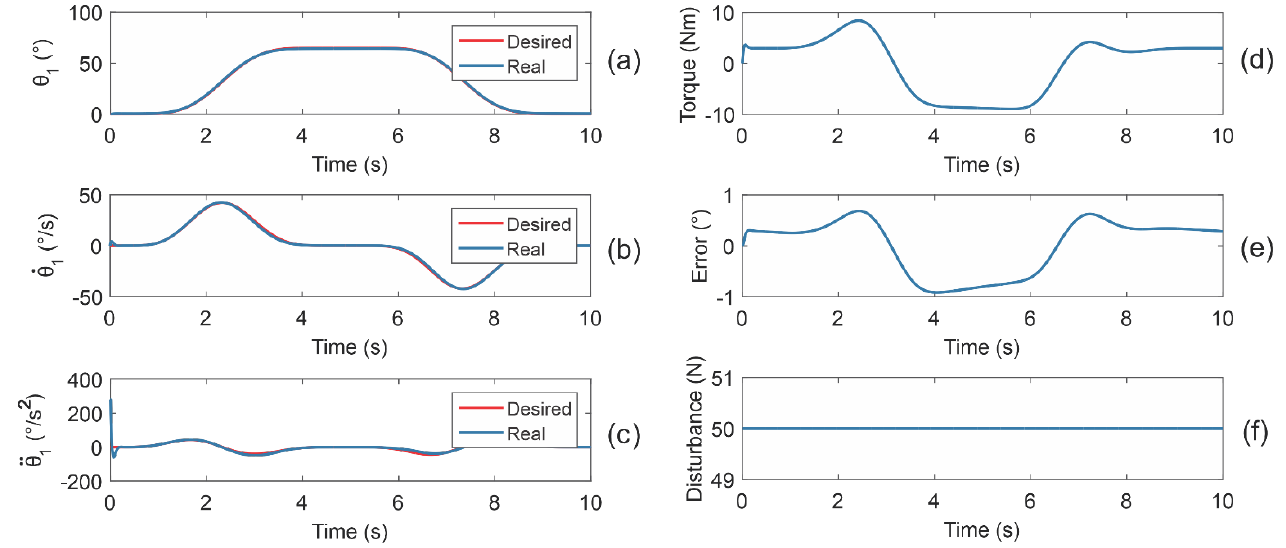
Figure 13. Reference trajectory tracking simulation with a constant disturbance input. ( a ), ( b ), and ( c ) are respectively the angular position, velocity, and acceleration of 𝜃 1 , ( d ) is the torque, ( e ) is the error, and ( f ) is the disturbance.